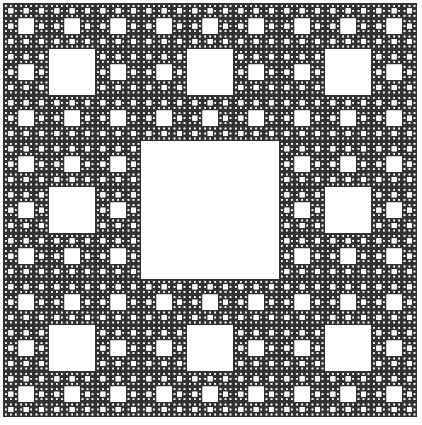
Figure 1: The Sierpiński carpet in E 2 satisfies the